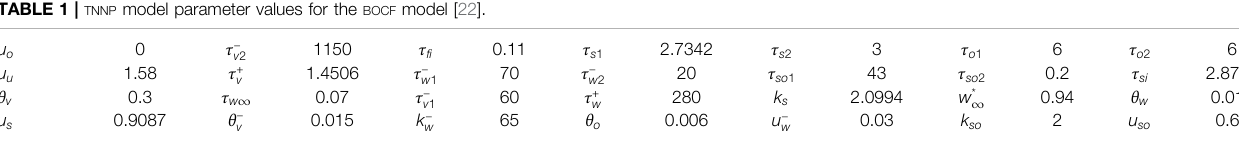
TABLE 1 | TNNP model parameter values for the BOCF model [22]. u o